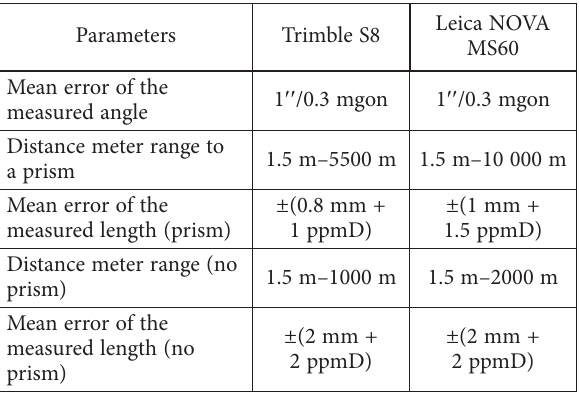
Table 1. Parameters of used geodetic instruments